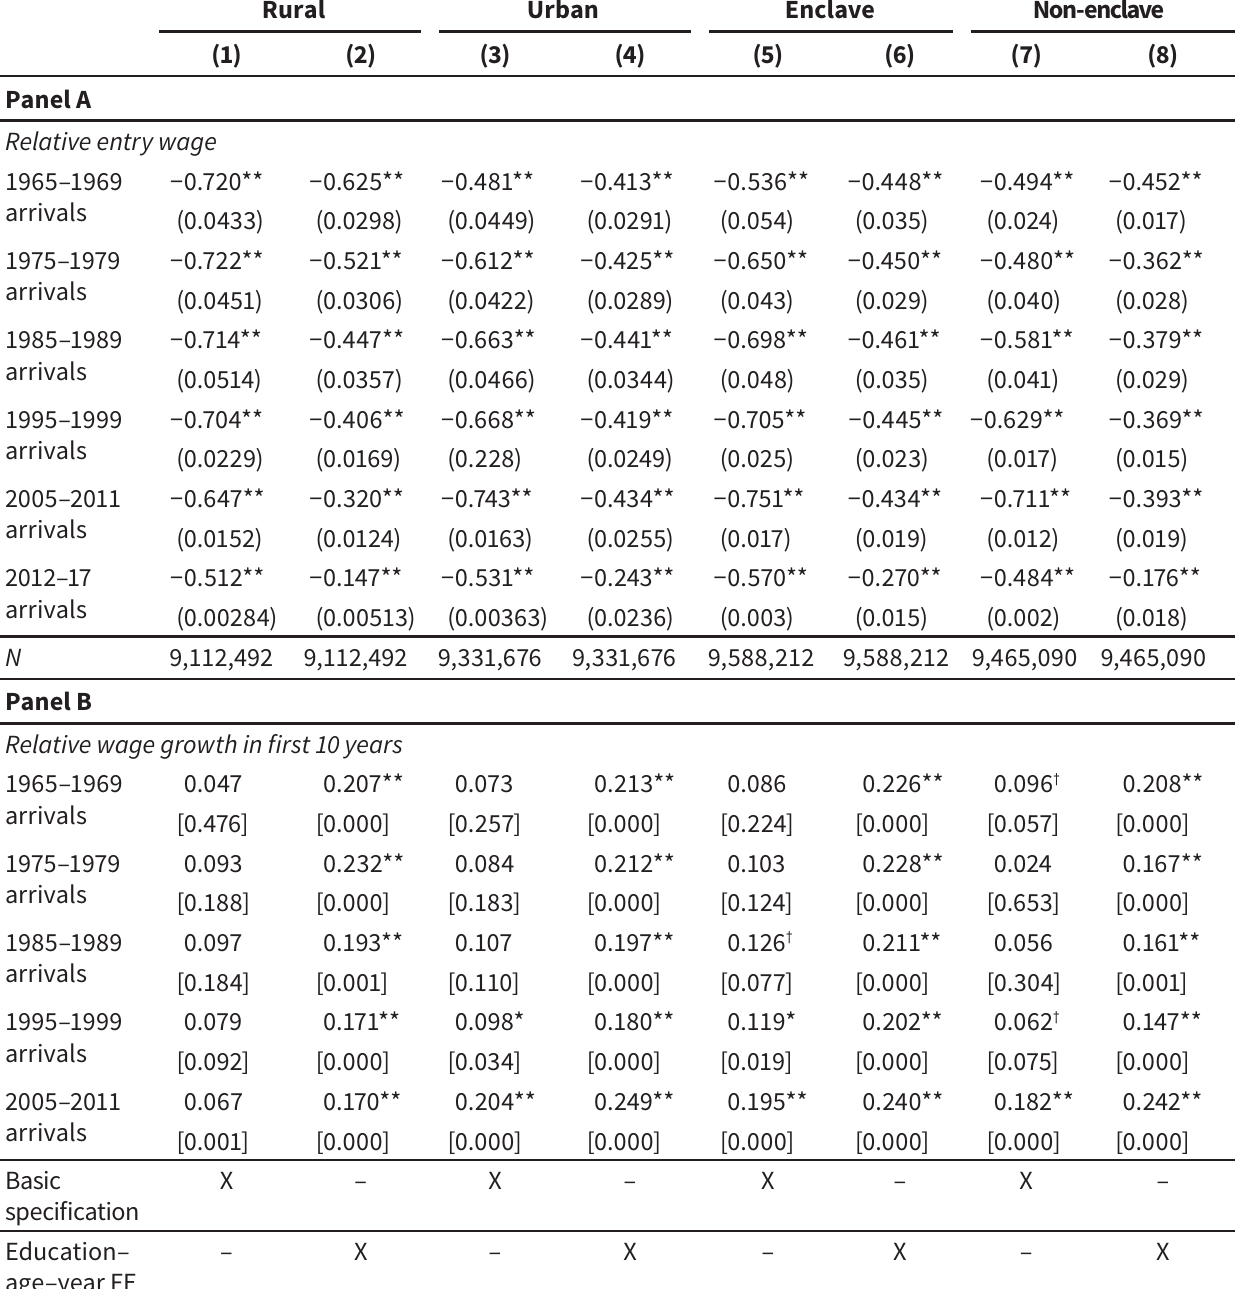
Mexican and Central American immigrants by location: initial gaps and convergences after first 10 years Rural Urban Enclave